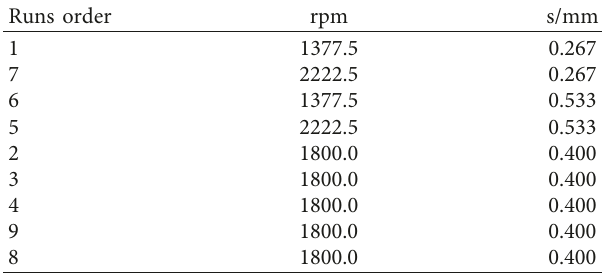
Table 1: Table data for two factorial designs with five centre points.